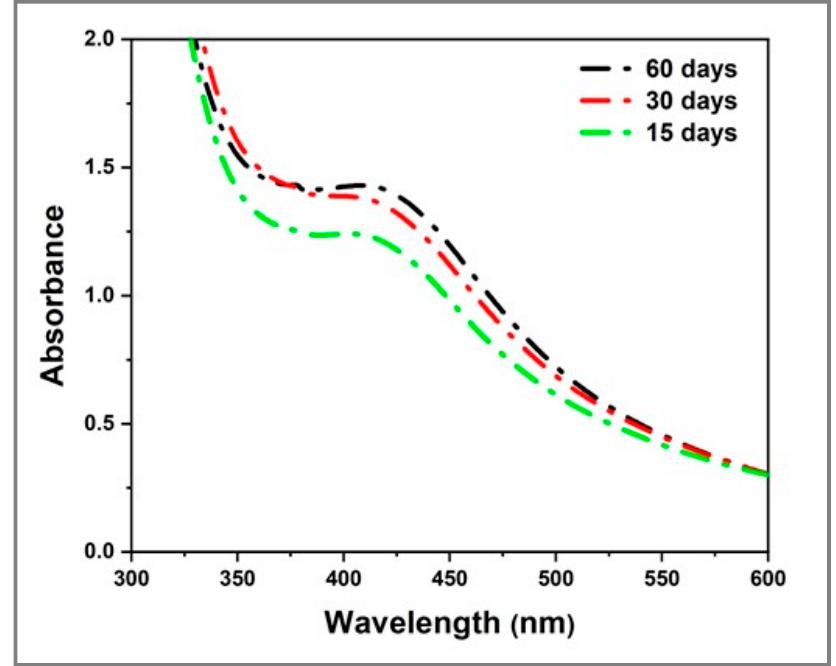
Figure 3. UV–Vis spectra of Ag 2 Se NPs obtained from sample E 4 (3.4 mM [Ag + ] f , 1.7 mM [Se 4+ ] f , 40 mg